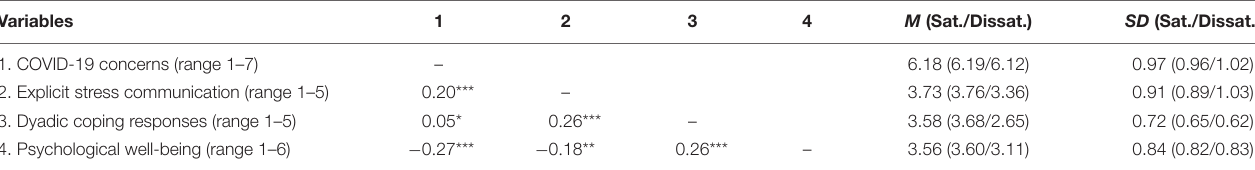
TABLE 1 | Correlations, means, and standard deviations for the study variables. Variables